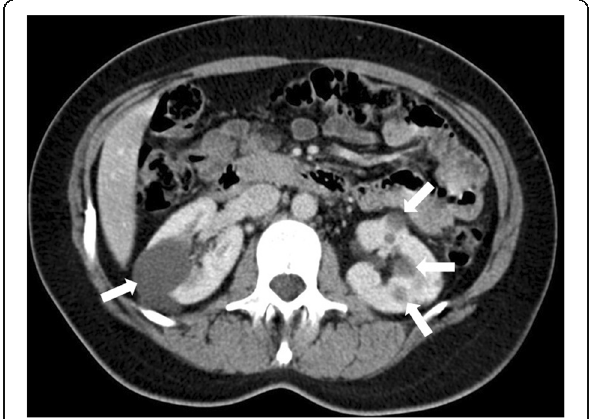
Fig. 14 A 34-year-old female patient with known hypertension and family history of ADPKD. Axial plane post-contrast CT image shows bilateral renal cysts with different sizes (arrows). Normal renal